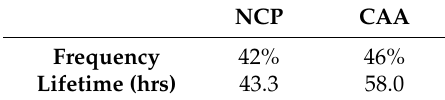
Table 2. The frequency and lifetime of ICs originated from the north of China using the NCP.